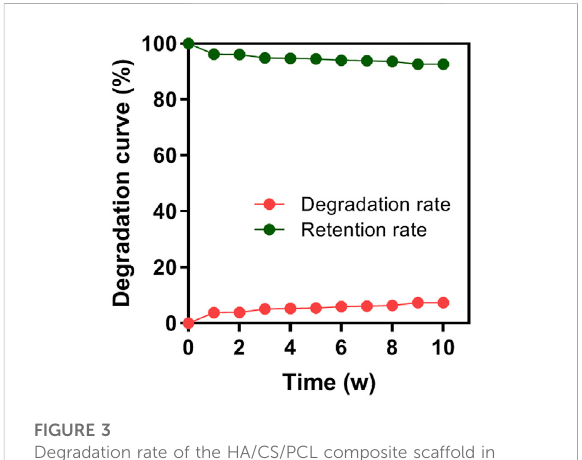
FIGURE 3 Degradation rate of the HA/CS/PCL composite scaffold in 1 – 10 weeks of immersion in simulated body fl uid (SBF).